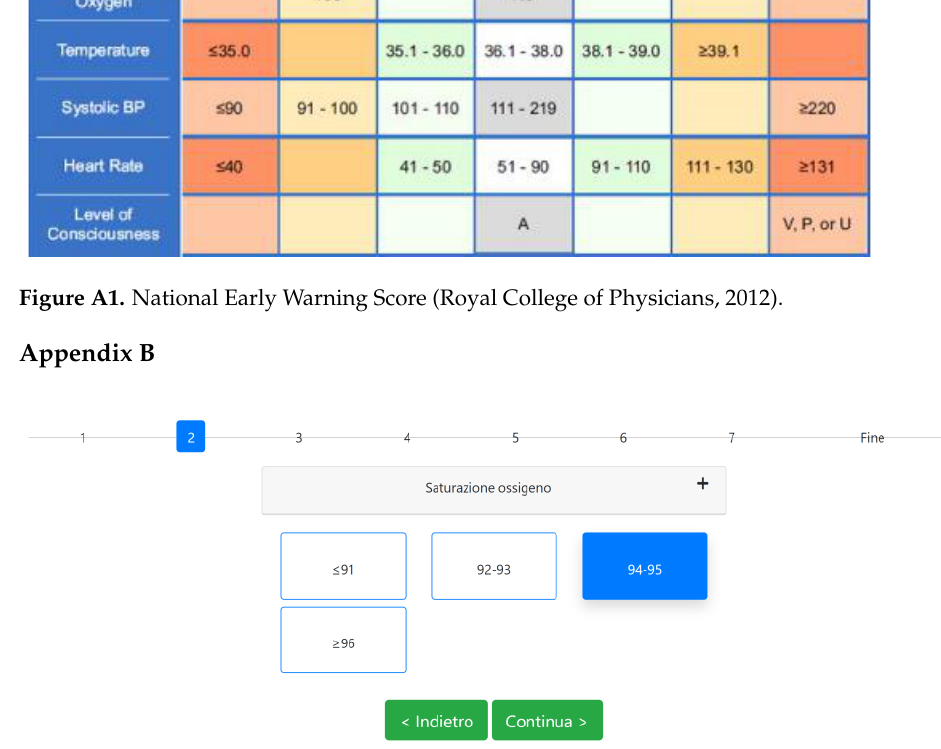
Figure A2. CovidUP19 Web-App